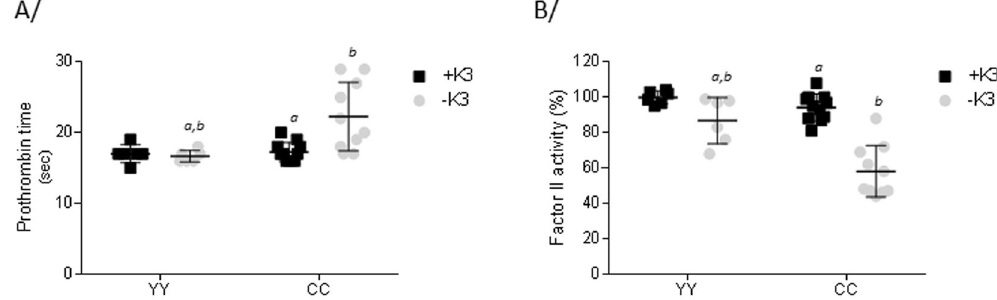
Figure 1. Influence of the diet on the coagulation function in YY and CC rats A /Prothrombin time expressed in seconds and B /factor II activity expressed as a percentage compared to the mean value obtained for YY + K3 group. In black squares, rats fed with standard diet; in grey circles, rats fed with diet –K3, during 12 weeks after the weaning. Results expressed as mean ± SD. n = 6 for groups YY and n = 11 and 10 for groups CC + K3 and CC − K3 respectively. * p < 0.05 vs YY + K3 group. Statistical analysis was performed using Tukey’s multiple comparisons test. Statistic difference was reported when only a unique variable between groups is modified (either genotype or diet). P < 0.01 was the accepted level of significance. a,b,c : statistical difference between 2